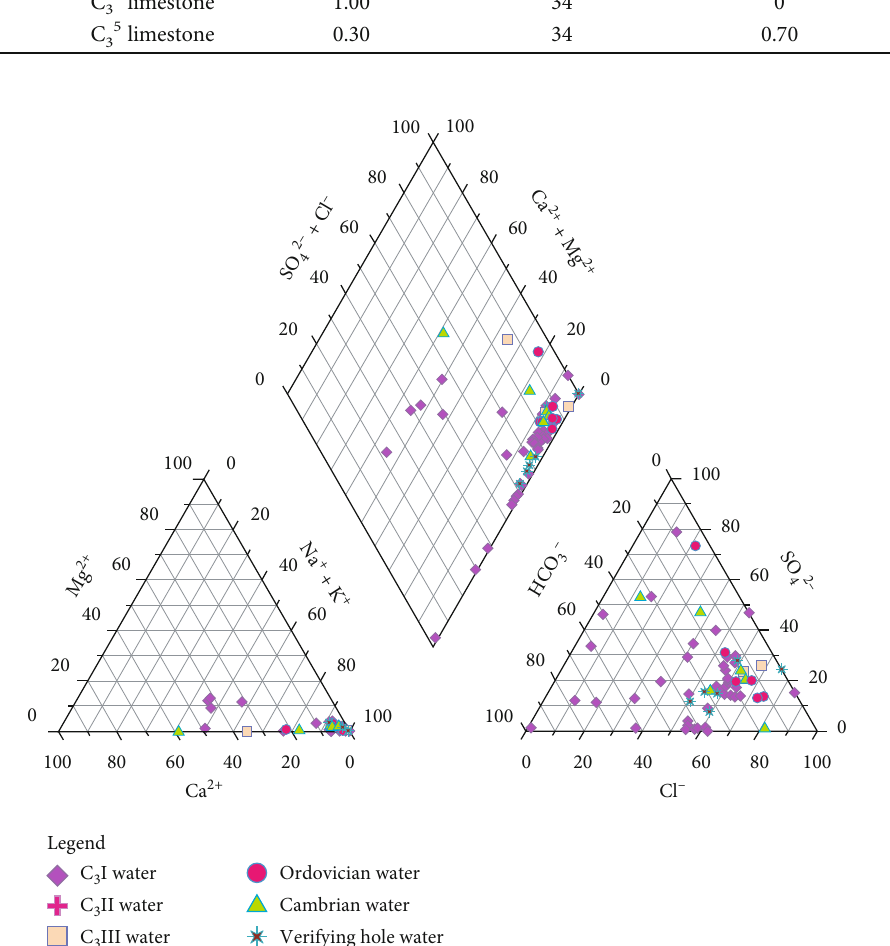
Figure 8: Comparative analysis of water chemistry characteristics. Taiyuan formation limestone water (C Ordovician limestone water, and Cambrian limestone water act as the background value to analyze to discriminate the veri fi cation hole out fl ow water